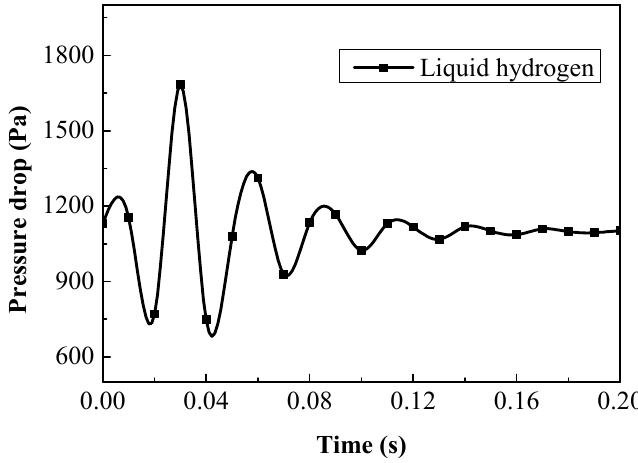
Figure 12. Variations in the pressure drop between the entrance and exit of the pipe with time.